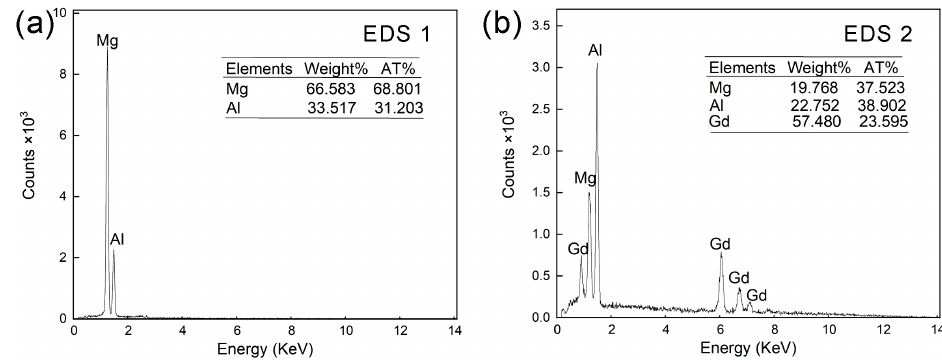
Figure 4. Results of EDS analysis performed at: ( a ) arrow 1 in Figure 3a, ( b ) arrow 2 in Figure 3d. The XRD analysis results and fitted curves obtained using the Rietveld method are presented in Figure 5. The quantitative phase analysis results are summarized in Table 2.